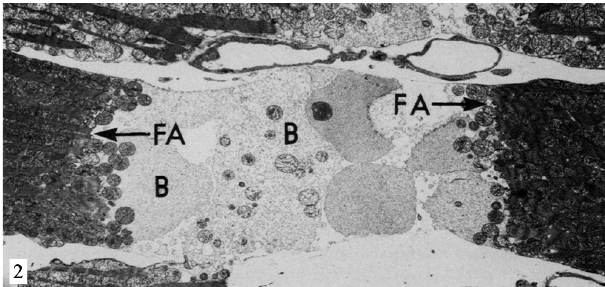
Fig. 2 - Electron micrograph of rat heart after 5 minutes in calcium- free perfusion, followed by 15 minutes with the addition of DNP at the first perfusate. The sarcomeres are contracted herein, pulling the fascia adherens (FA) and causing damage to the cell membrane of the myocyte in the nexus area. The cytosol is exteriorized in the form of blebs (B) in the intercellular region. Reproduced from Ganote et al., 1985